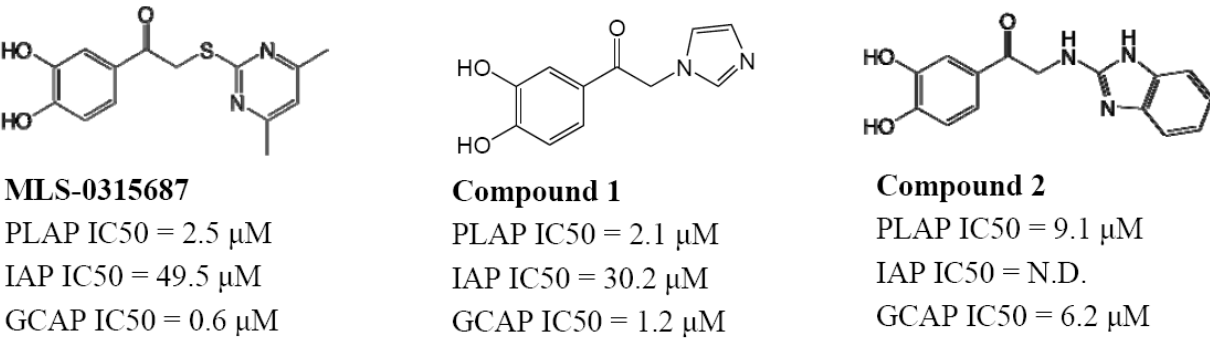
Figure 11. PLAP selective compounds with additional selectivity over GCAP